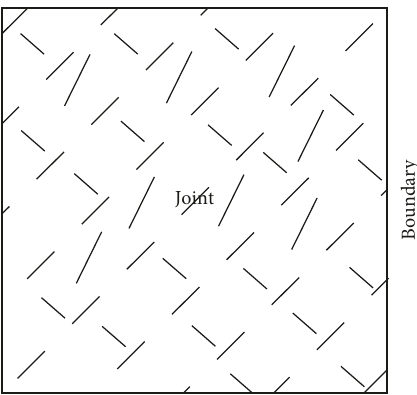
Figure 20: Sketch of multiple joints.